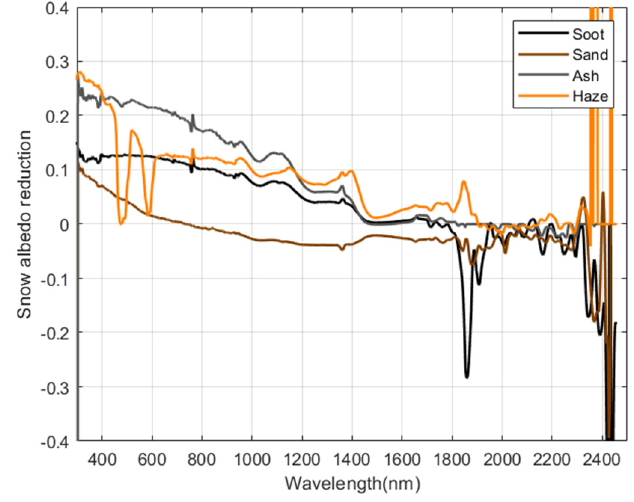
Figure 11. Snow albedo reduction from “clean” to contaminated with soot, sand, ash, and haze, obtained from the experimental results. Negative values correspond to snow albedo increases, as in the case of sand.